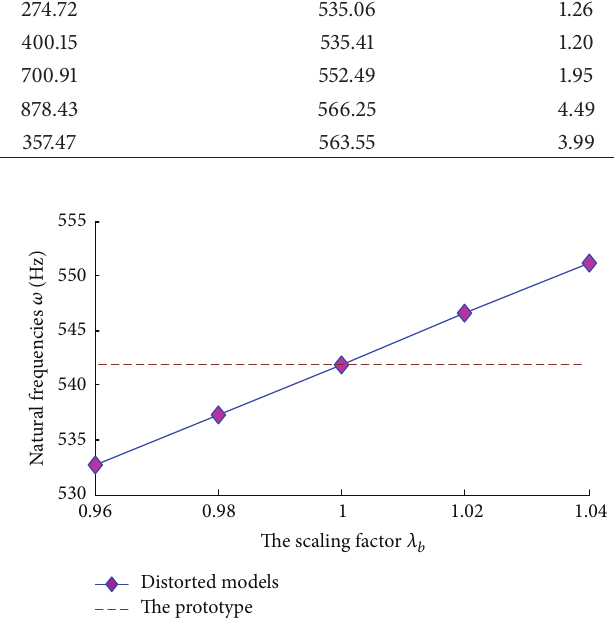
Figure 4: The fitted curve of inner radius distorted